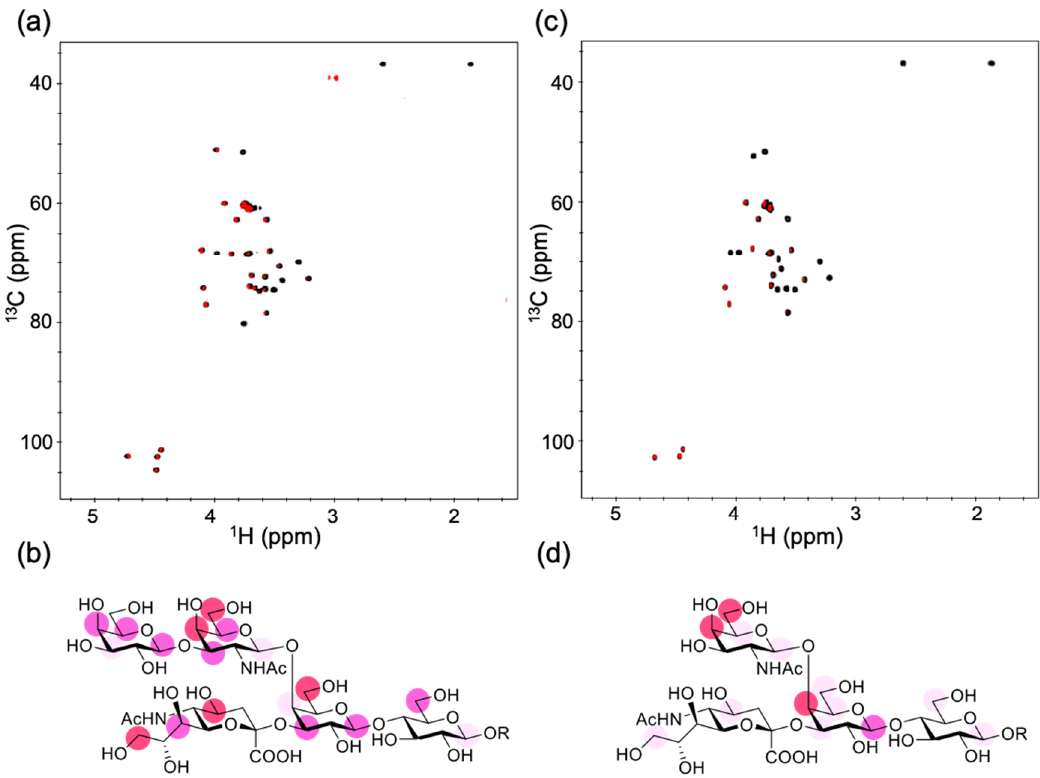
Figure 1. NMR observation of the interaction of gangliosidic oligosaccharides with GB2. ( a ) Overlay of the 2D 1 H– 13 C heteronuclear single-quantum correlation (HSQC) spectrum (black) and the 1 H– 13 C saturation transfer difference (STD)-HSQC spectrum (red) of the 2-trimethylsilylethyl derivatives of the GM1 pentasaccharide (10 equiv.) with 50 μM GB2. ( b ) Mapping of the binding epitope of the GM1 pentasaccharide. ( c ) Overlay of the 2D 1 H– 13 C HSQC spectrum (black) and the 1 H– 13 C STD-HSQC spectrum (red) of the 2-trimethylsilylethyl derivatives of the GM2 tetrasaccharide (10 equiv.) with 50 µ M GB2. ( d ) Mapping of the binding epitope of the GM2 tetrasaccharide. In ( b , d ), the maximum peak intensity of each oligosaccharide was taken as 100%, and the relative intensities (over 80% red, over 65% pink, over 50% light pink) are indicated. R represents a 2-trimethylsilylethyl group.